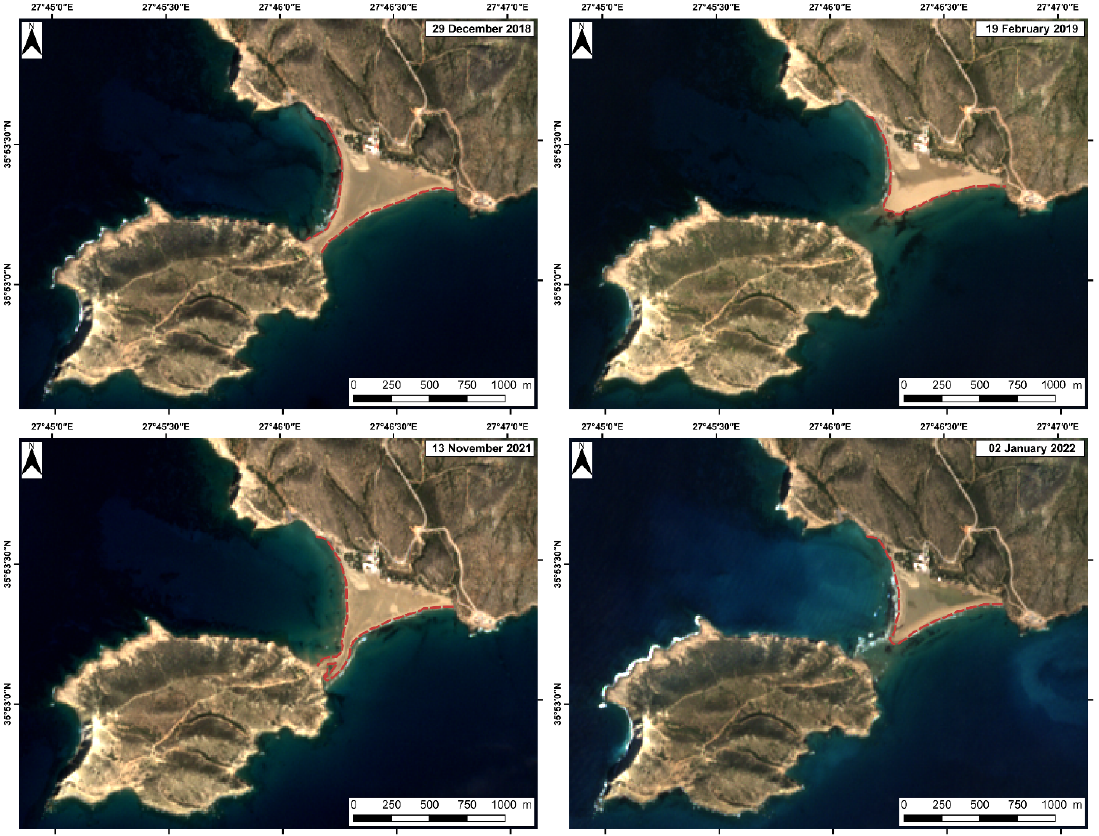
Figure 9. Satellite images of the Prasonisi tombolo ( left ) and salient ( right ) formation in two cycles, covering the time periods of 30/8/2013–2/6/2021 ( up ) and of 2/6/2021–8/2/2022 ( below ) (https://apps.sentinel-hub.com/). Figure created in QGIS.